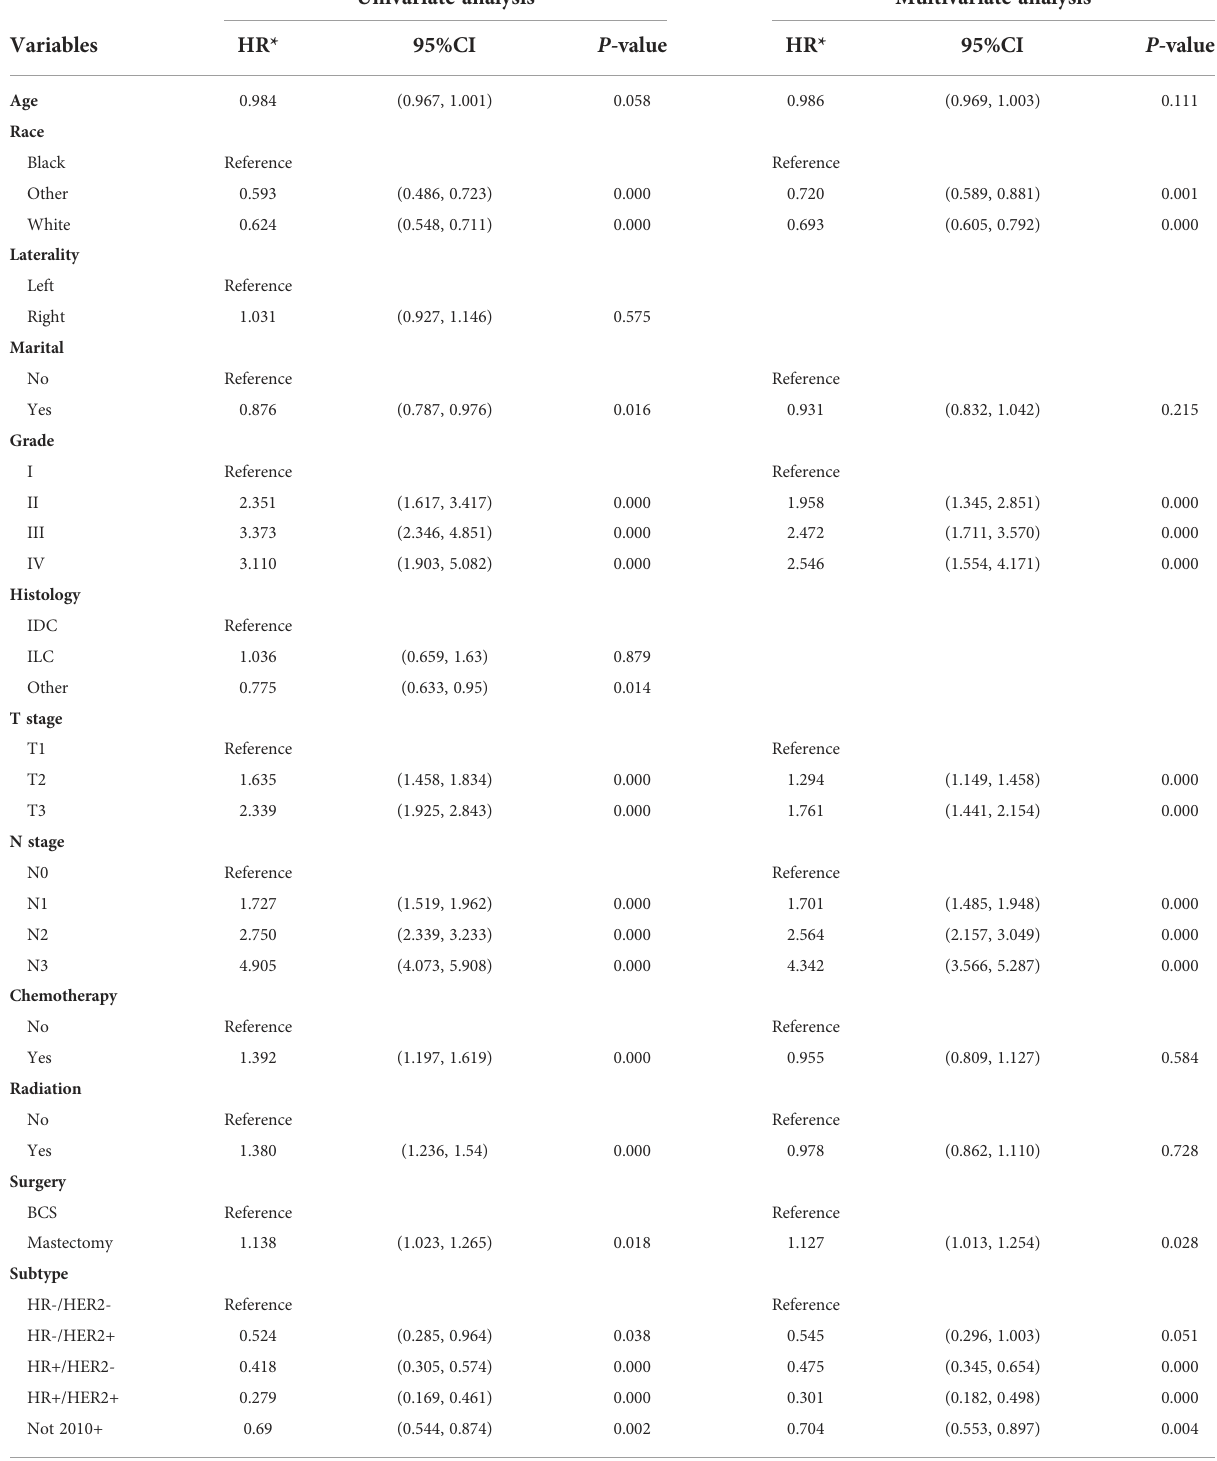
TABLE 3 Univariate and multivariable analysis of overall survival (OS) predictors in breast cancer patients after PSM. Univariate analysis Multivariate